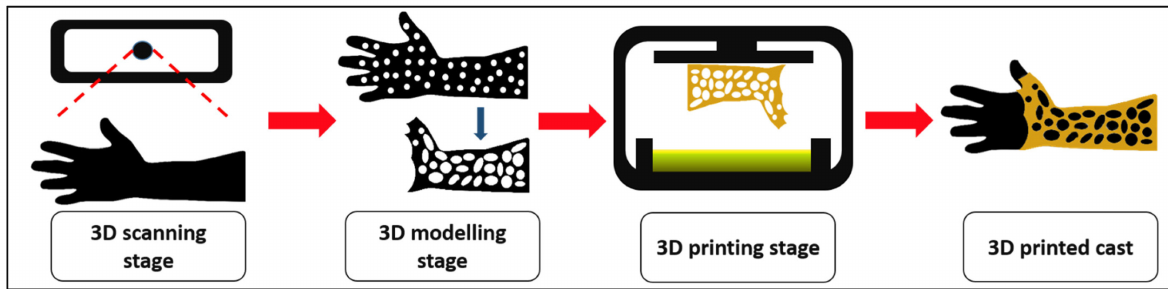
Figure 12. The development of 3D printed cast.